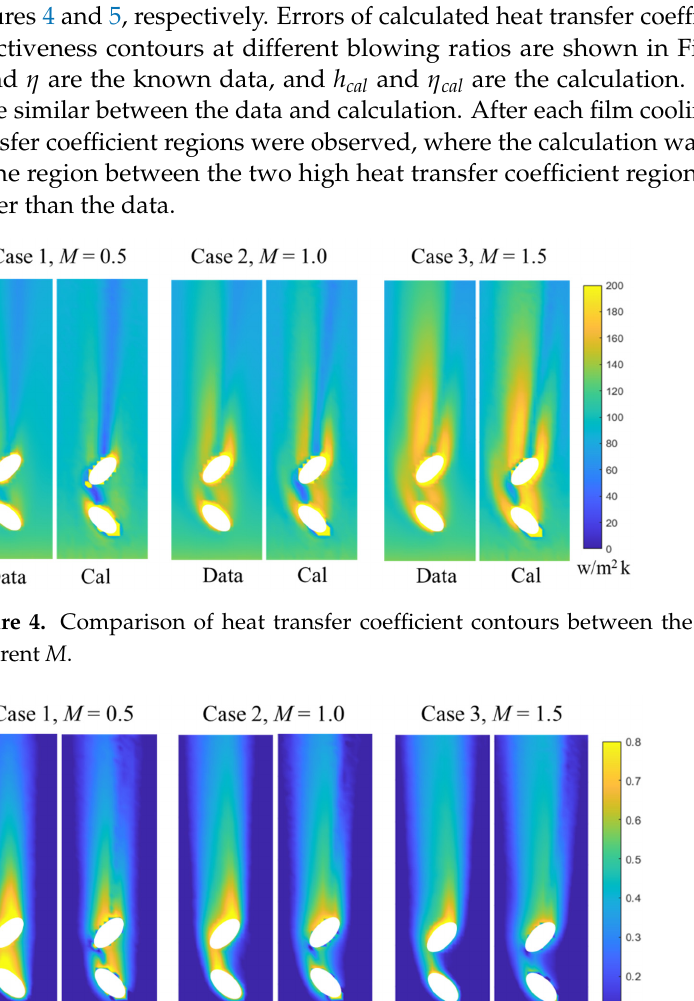
Figure 6. Errors of calculated heat transfer coefficient and film cooling effectiveness at different M . Figure 9 and Figure 10 present errors of calculated heat transfer coefficient and film cooling effectiveness contours at M = 1.0 for cases 4 to 10, respectively. For cases 4 and 5, errors decreased when h increased from 0.5 h 0 to 2 h 0 . For cases 6 to 9, different mainstream temperatures ere tested. For case 10, local errors decreased significantly when k decreased from 0.2 W/(m·K) to 0.05 W/(m·K). At k = 0.05 W/(m·K), the local percentage error of h and the local error of η were mainly less than 6% and 0.04, respectively.